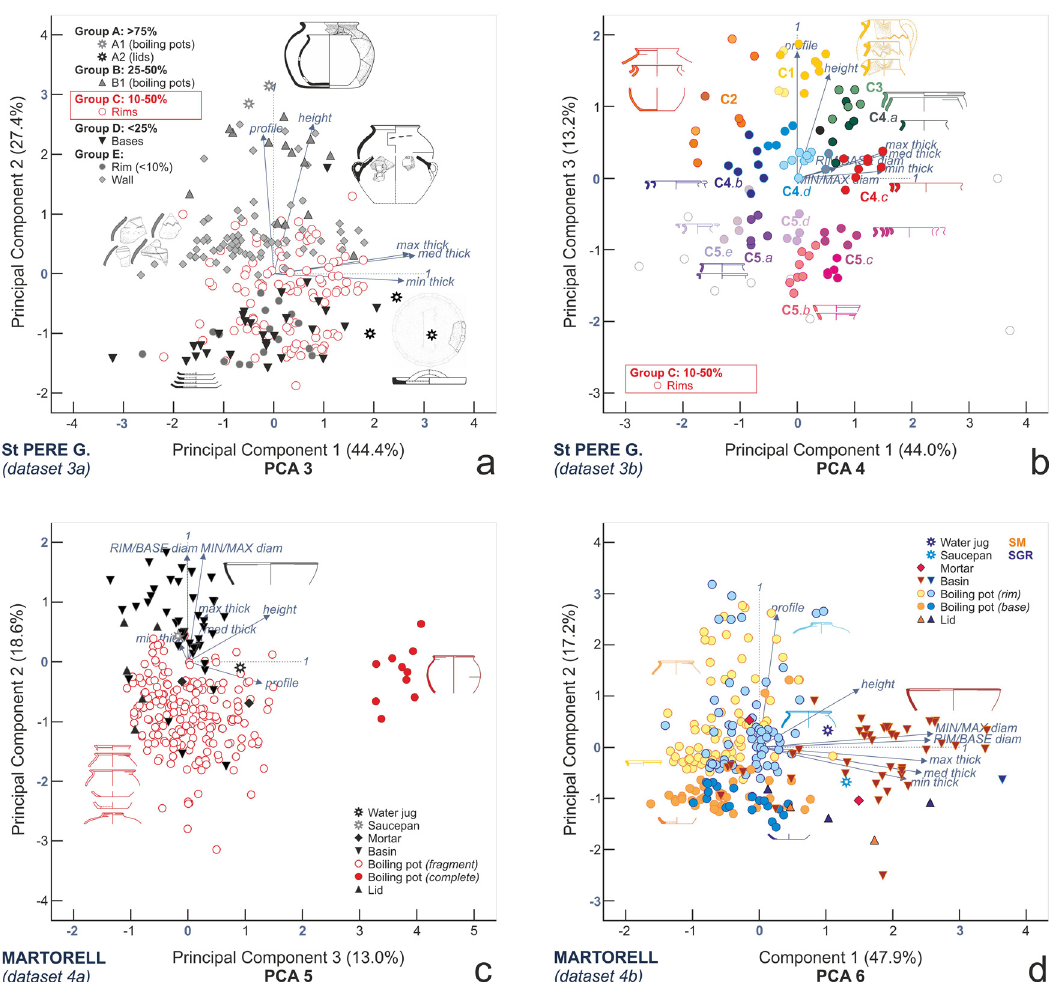
Figure 5: Scatterplots of PCA of the morphometric data of pottery samples from Sant Pere de Graudescales ( a and b ) and Martorell ( c and d ) . In datasets from highly broken samples, fi rst analysis determines breakage groups, while second – and more re fi ned – analysis of speci fi c subdatasets allows for the identi fi cation of typological clusters and potential morphological di ff erences between